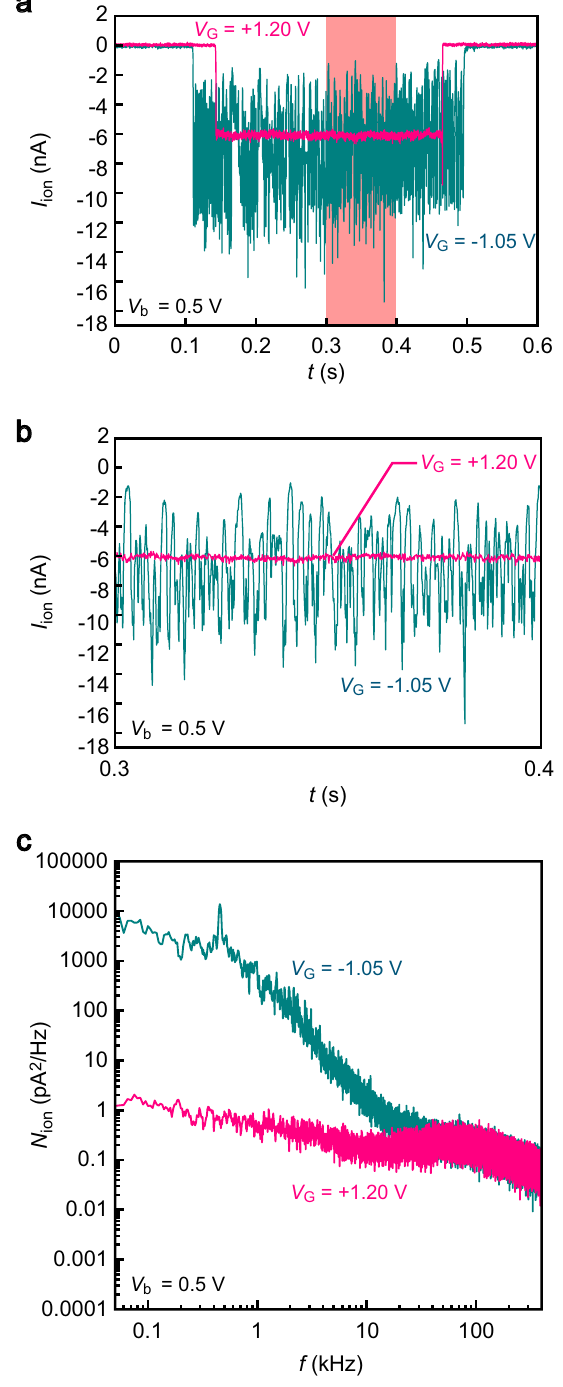
Fig. 4 Harmonic oscillation of single-nanoparticles. a Offseted I ion curves presenting ionic current blockade by a 200 nm-sized nanoparticle under V = − 1.05 V (cyan) and + 1.20 V (pink). b Close-up views of the two G signals in a . c Noise spectra of the I ion – t traces. Color code is the same as that in a